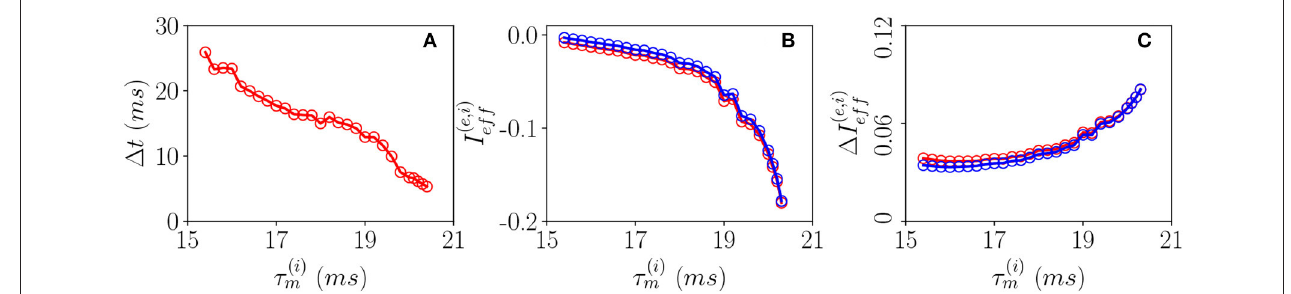
FIGURE 6 | Pyramidal-interneuron gamma (PING)-like O P COs. (A) Firing delays 1 t between the excitatory population peak and the inhibitory one vs. τ ( i ) m . Effective mean input currents (Equation 13) (B) and current fluctuations (Equation 20) (C) vs. τ ( i ) m , the excitatory (inhibitory) population are denoted by red (blue) circles. All the data reported in this study refer to MF simulations. The parameters are I ( e ) 0